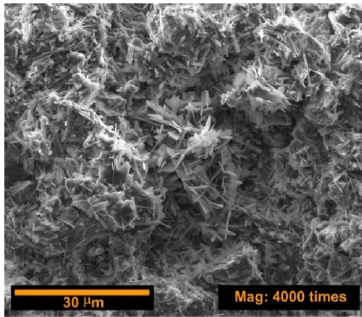
Figure 2. SEM picture of a cement matrix containing the C-S-H seeds after 4 h of curing.